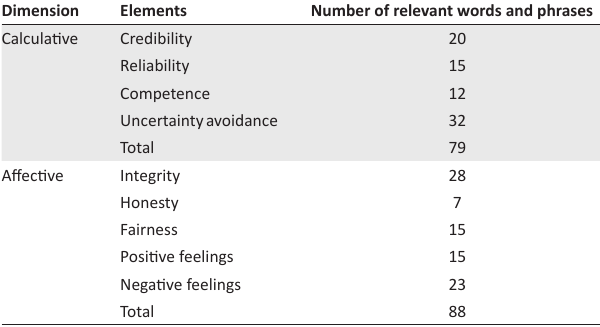
TABLE 2: Results of content